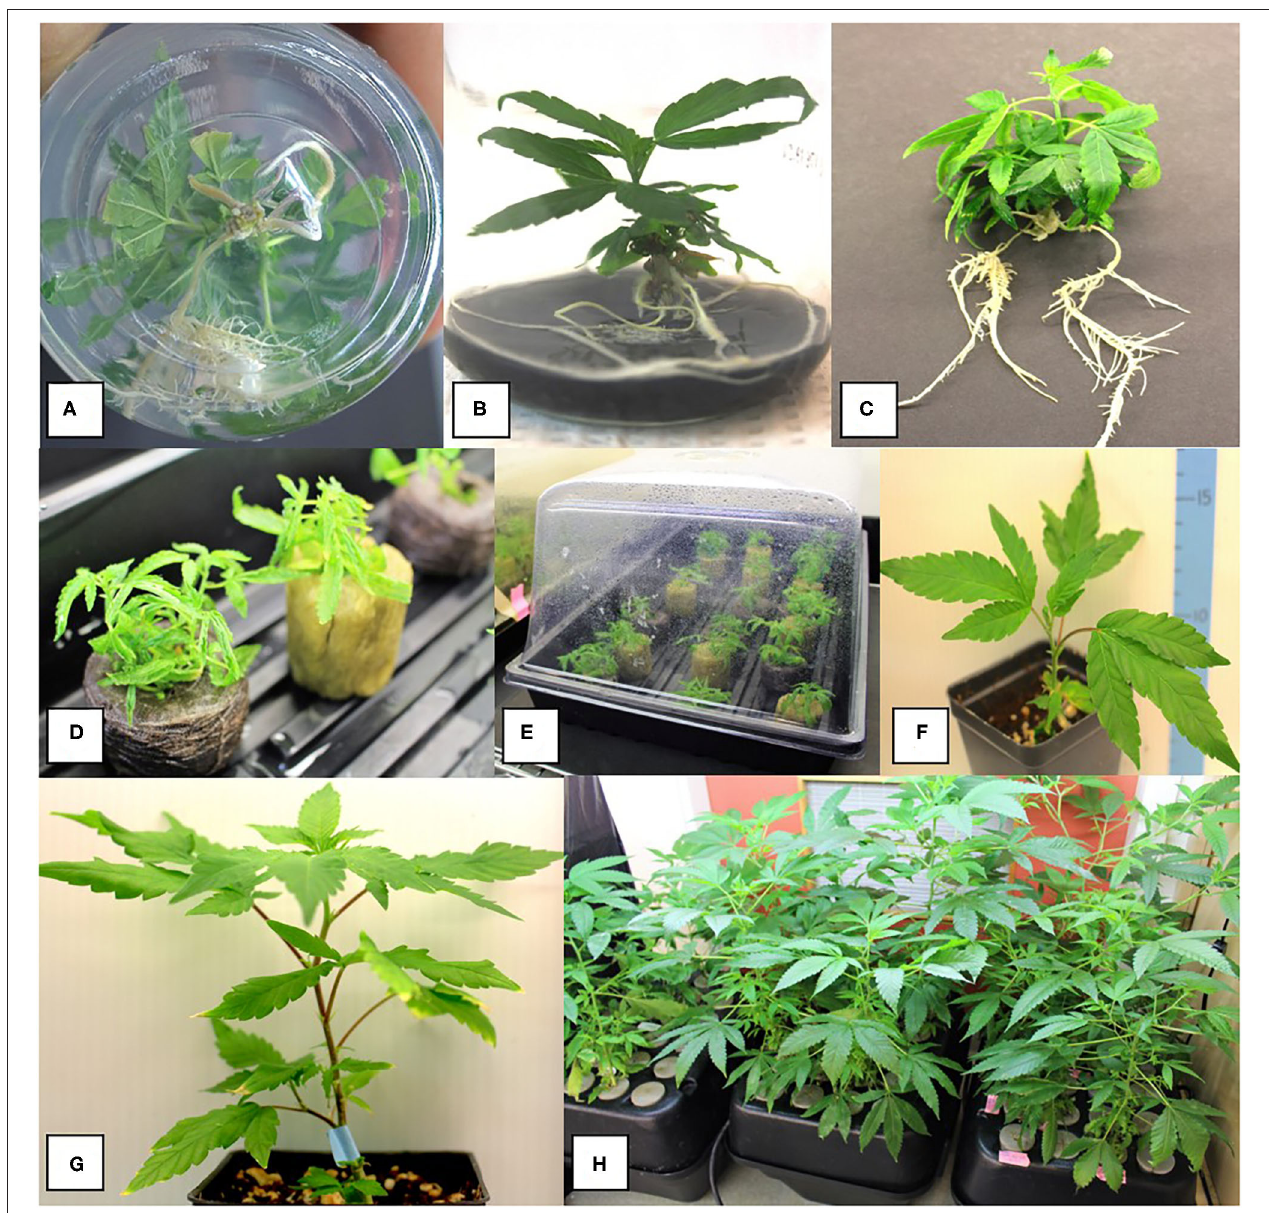
FIGURE 8 | Root development on shoots after 8–10 weeks of growth in tissue culture and acclimatization to produce plants. (A,B) Spontaneous development of roots on nodal explants. (C) Plantlets were removed from tissue culture and transferred to coco growth media and placed under high humidity conditions for 2 weeks. (D,E) Acclimatization of plantlets from meristems of genotype MBD in different growth substrates. Plantlets were removed from tissue culture jars after 12 weeks of growth on the MM and placed into rockwool or peat under humid conditions for 14 days. Rockwool or peat plugs were soaked in a fertilizer mix of 1 ml/L of pH Perfect ® Sensi Grow A&B and CALiMAGIc (General Hydroponics, Santa Rosa, CA, United States) in ∼ pH 5.8 water. (F,G) Growth of plants on a coco potting medium under ambient conditions following successful acclimatization. (H) Hydroponic system filled with 8L of the fertilizer mix with vigorous growth of plants derived from meristem tissue